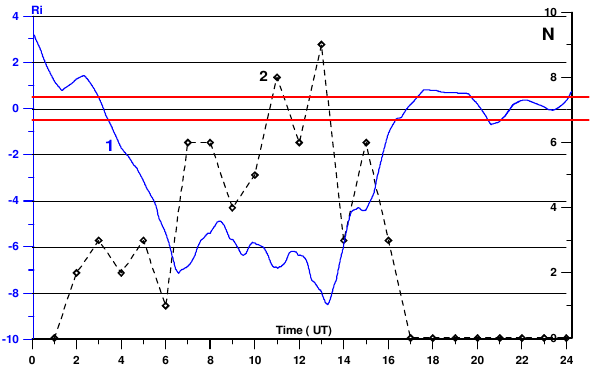
Fig. 5. Dynamics of the number of AES per hour ( N , dashed black) and the gradient Richardson number ( Ri , blue line) during 30 July. The two horizontal red lines correspond to Ri values –0.5 and 0.5.